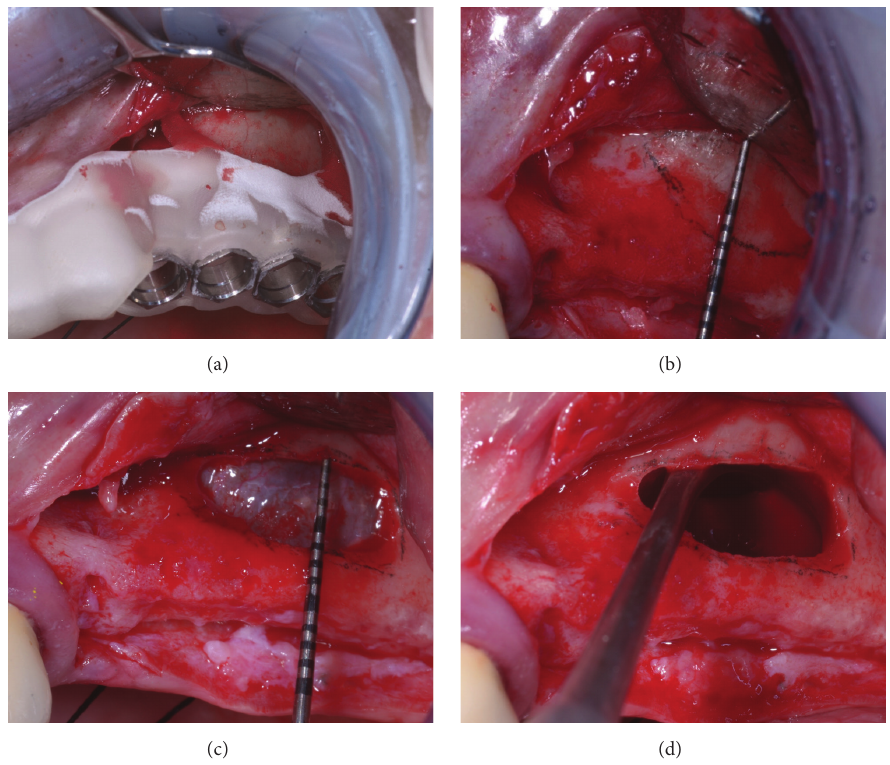
Figure 9: The preparation of the antrostomy and the elevation of the sinus membrane. First, the window is drawn on the vestibular bone wall with the aid of the surgical guide (a). The window is no more than 6mm high (b). After performing the osteotomy (c), the sinus membrane is fully elevated